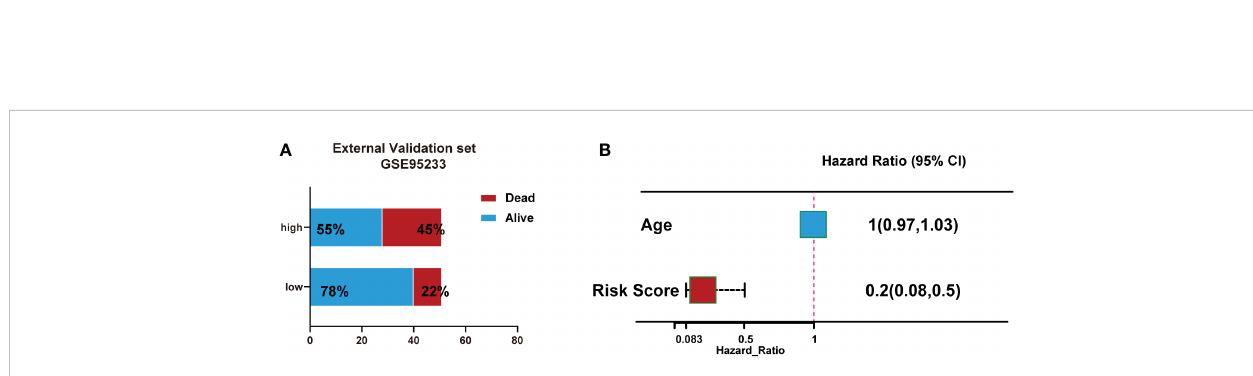
FIGURE 7 Validation of the signature using an external validation dataset (GSE95233). (A) Number of patient deaths increased with rising risk scores. (B) Multivariate logistic regression analysis showed that risk score was independently associated with survival.